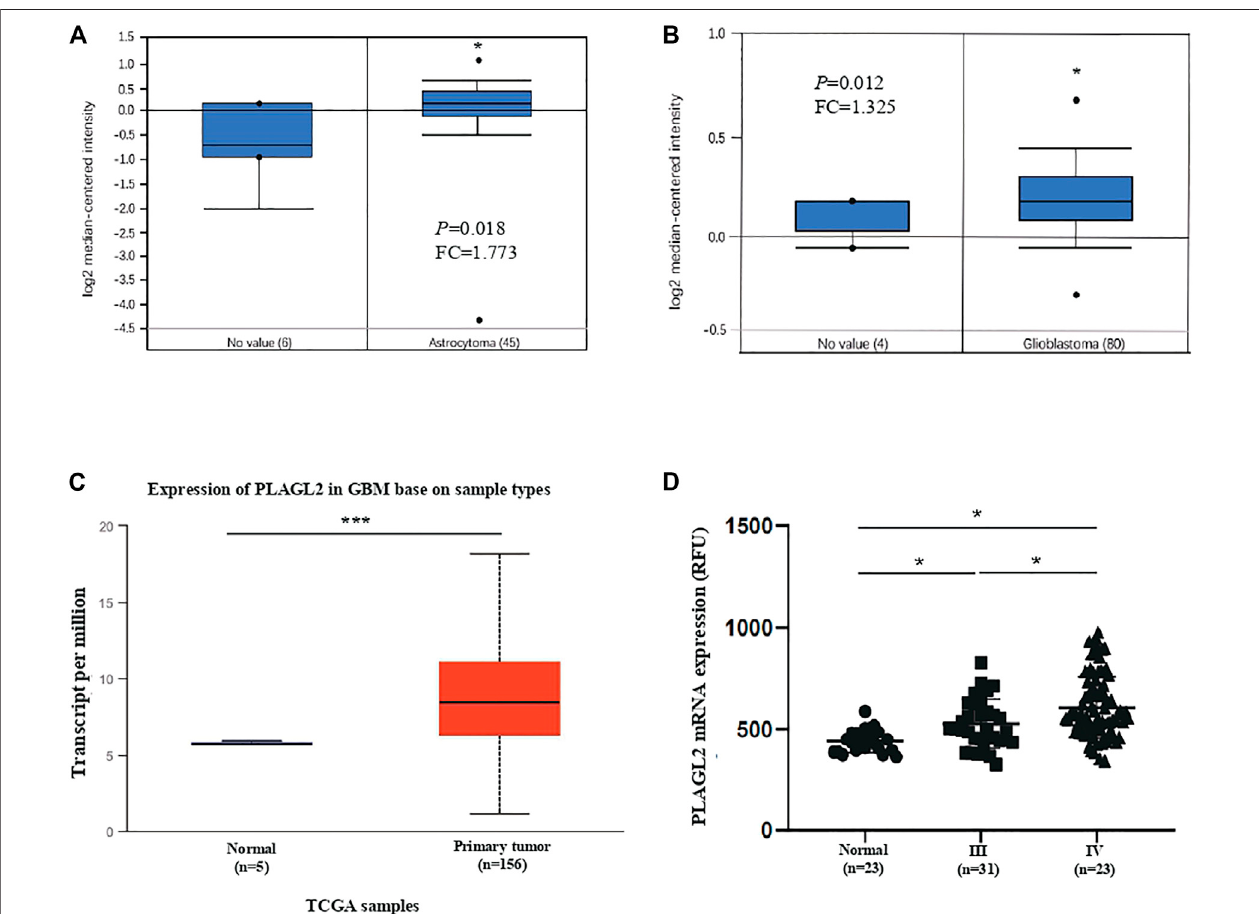
FIGURE 2 | Analysis of PLAGL2 expression in HGG and normal brain tissues with microarray datasets of glioma and log2 median intensity mRNA. (A,B) PLAGL2 mRNA expression in human gliomas was analyzed in GBM tissues and non-tumor brain tissues from the Richman brain and Murat brain datasets in ONCOMINE database. (C) Boxplot showing expression of PLAGL2 increased in GBM cancer tissues compared with adjacent normal in UALCAN. (D) Expression of PLAGL2 in glioma samples of the GSE4290 dataset.